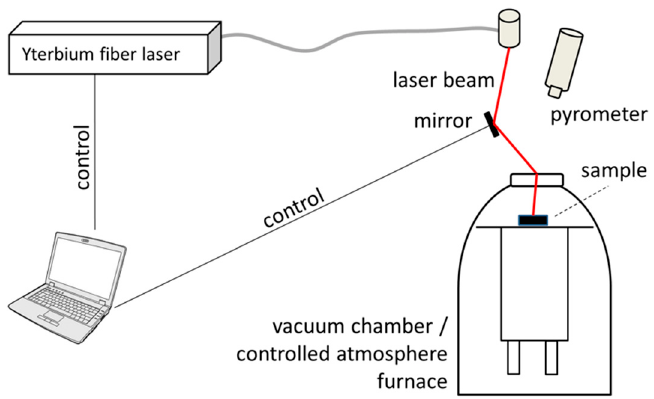
Figure 1. Schematic view of the experimental set-up used for the alloy fabrication.